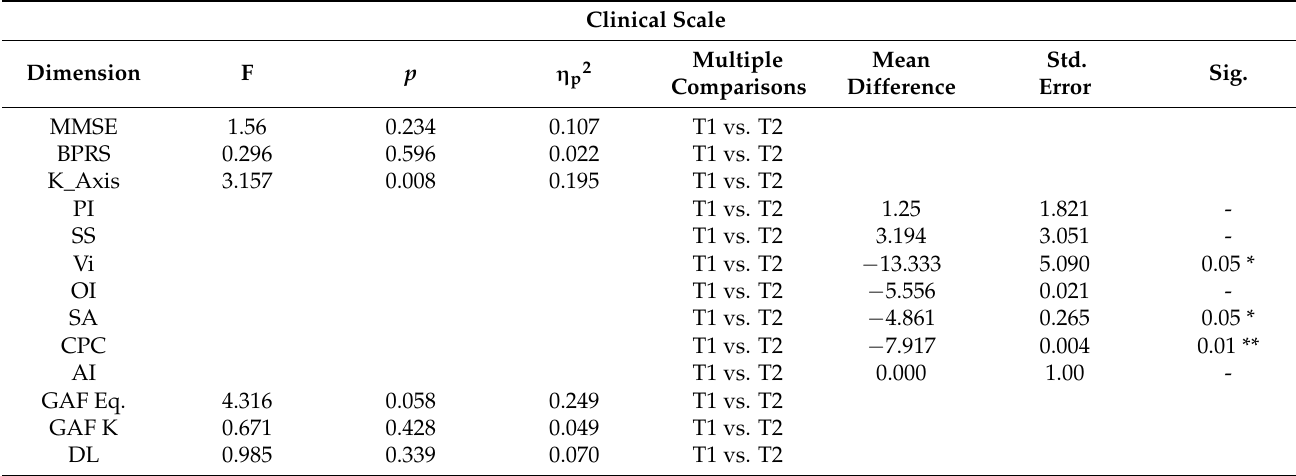
Table 3. Between administration-time differences